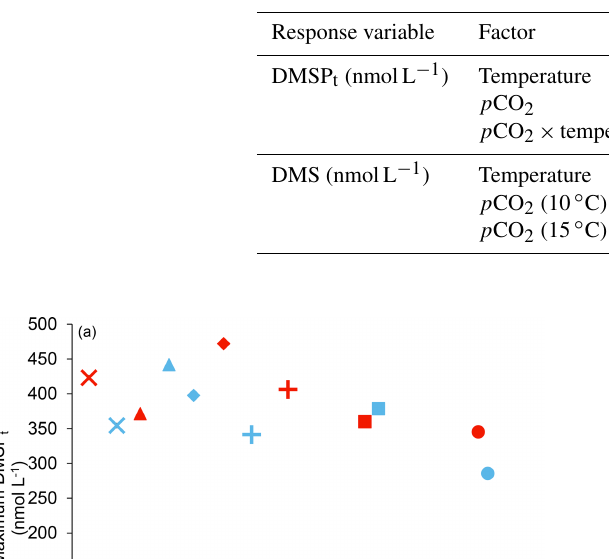
Table 2. Results of the generalized least squares models (gls) tests for the effects of temperature, p CO 2 , and their interaction on the maximum values of the parameters measured during the experiment. Separate analyses with p CO 2 as a continuous factor were performed when temperature had a significant effect. Maxima of DMSP t and DMS concentrations are presented with corresponding degrees of freedom (df). Significant results are in bold.